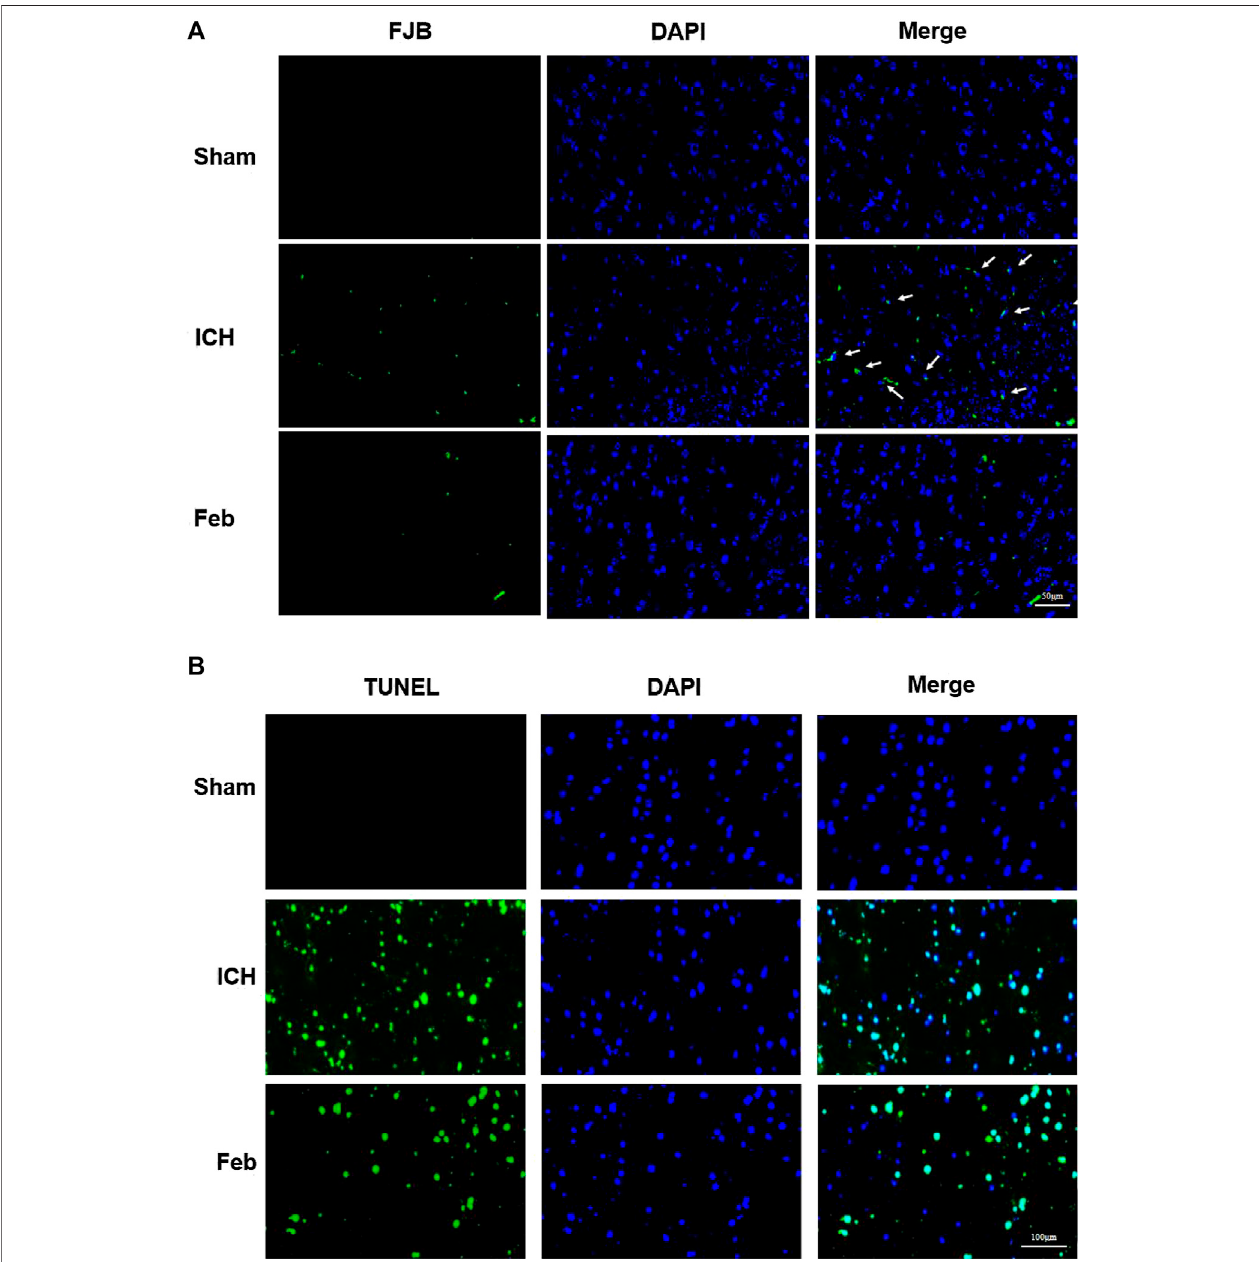
FIGURE2| FebuxostatattenuatedneurodegenerationafterICH: (A) DegeneratingneuronsinthebrainsectionswerelabeledwithFJBstain.Neuronaldegradation wasstained green. White arrows indicate colocalization.The scale bar is50 μ m. (B) Apoptotic neurons in thebrain sections were labeled withthe TUNEL stain. TUNEL- positive cells are shown in green. The scale bar is 100 μ m. Sections were stained with DAPI (blue) to show all nuclei.